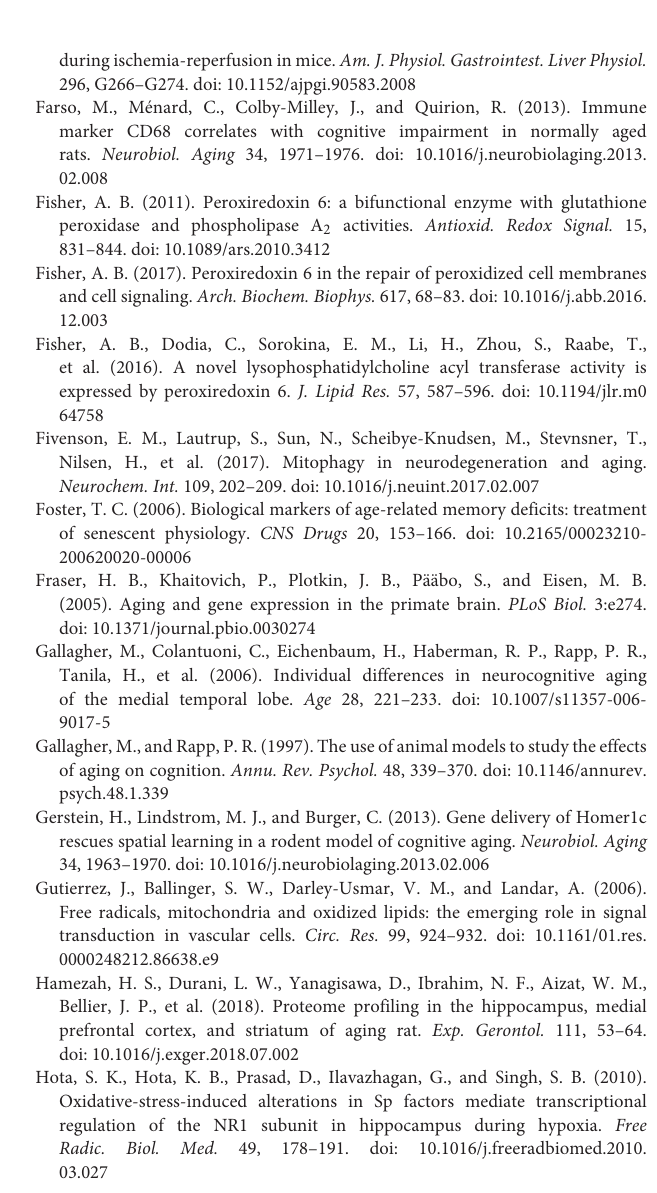
TABLE S2 | Weight of the rats on the day of